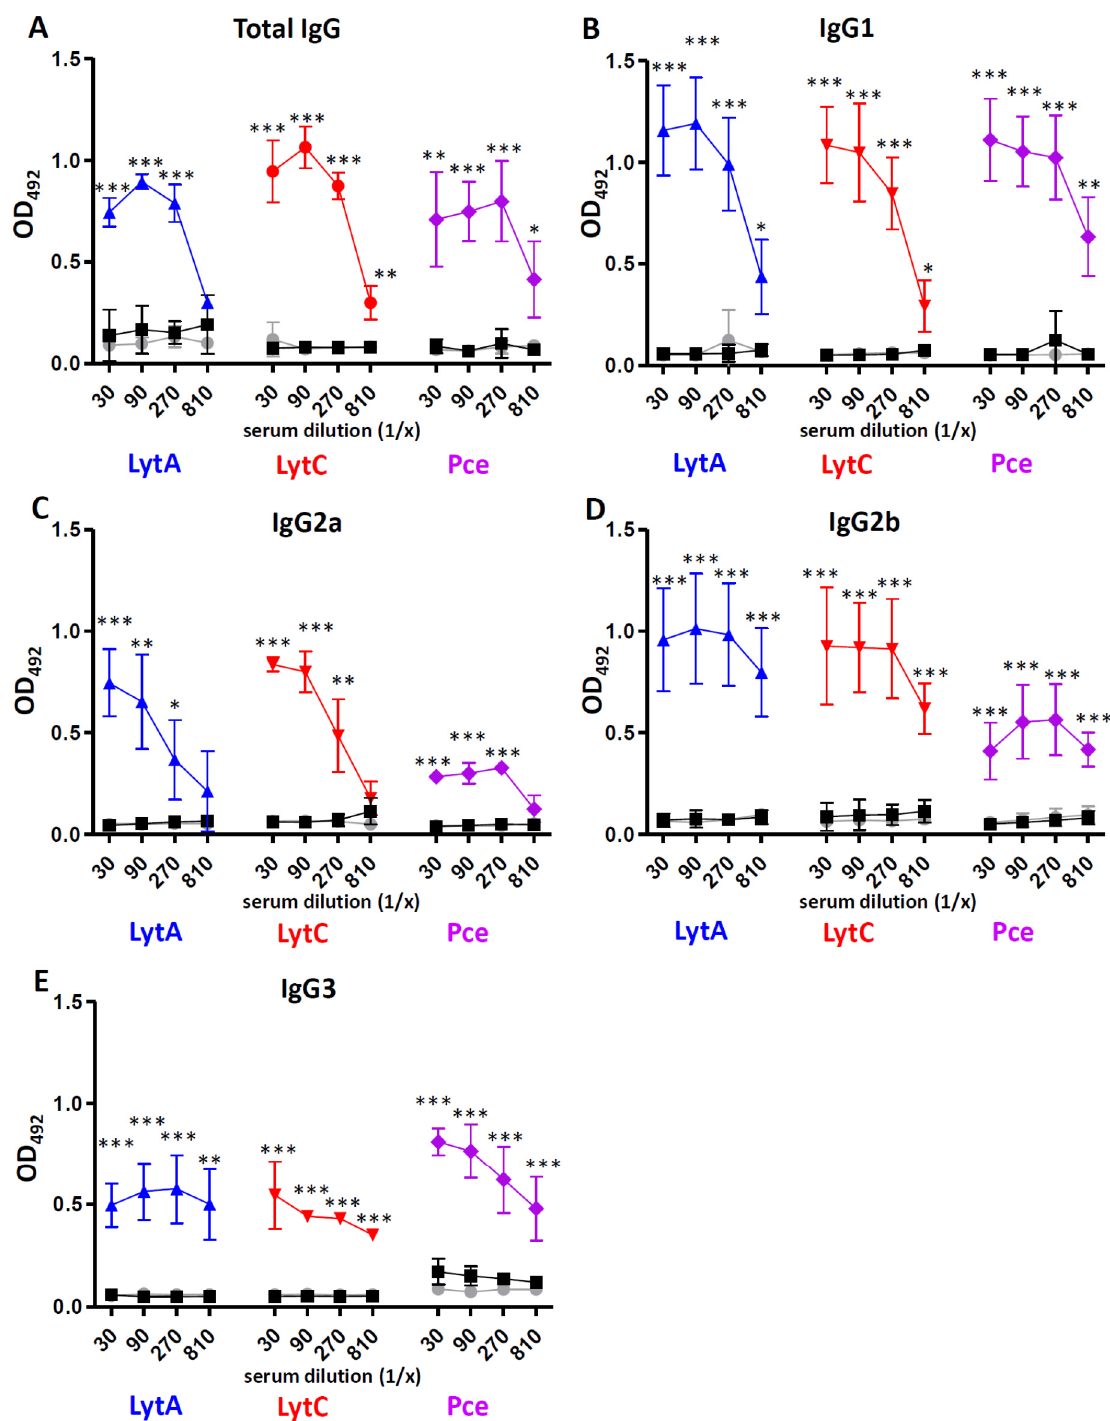
Figure 1. Antibody levels in sera after immunization of mice with Alum or different cell wall hydrolases (LytA, LytC, or Pce) mixed in Alum including total IgG ( A ), IgG1 ( B ), IgG2a ( C ), IgG2b ( D ), and IgG3 ( E ). Specific antibodies were measured in NMS (gray circles), pooled sera from mice immunized with Alum as adjuvant (black squares) and pooled sera from mice immunized with 20 µ g of LytA-Alum (blue triangles), LytC-Alum (red circles), or Pce-Alum (purple diamonds). Error bars represent the SDs and asterisks indicate statistical significance of immunization of each protein compared to the Alum group; * p < 0.05; ** p < 0.01; *** p < 0.001.